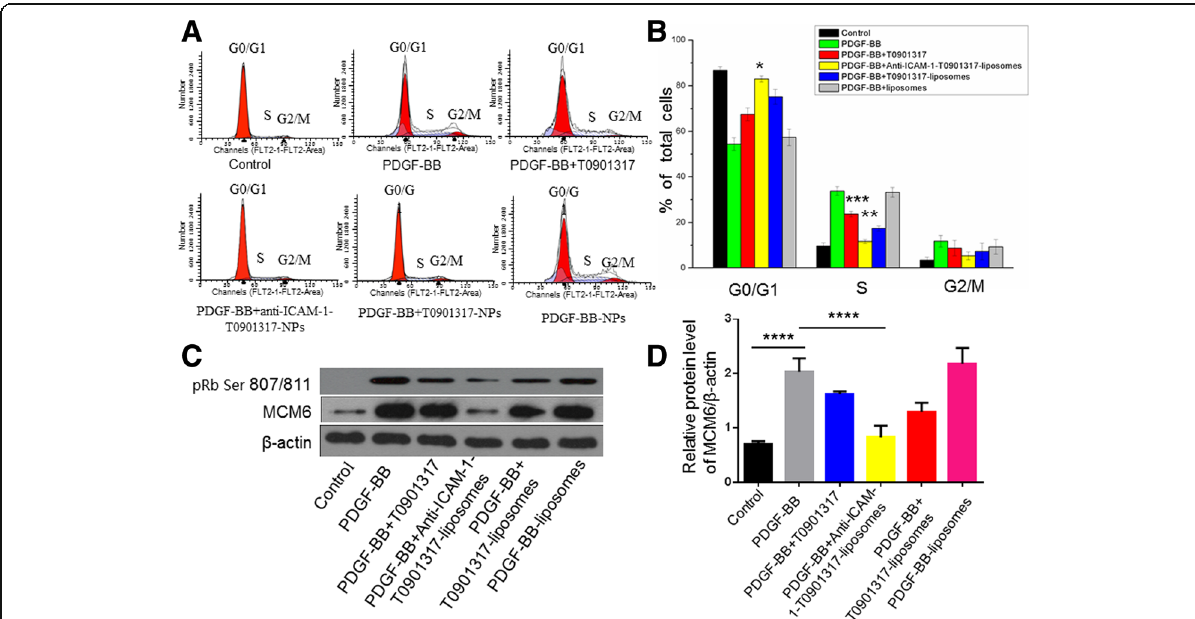
Fig. 7 Anti-ICAM-1-T0901317 liposomes inhibit PDGF-BB-induced G1 → S phase progression by inhibiting Rb phosphorylation and MCM6 expression. Cells were pre-treated for 24 h with PDGF-BB (20 μ g/mL) followed by treatment with targeted and nontargeted liposomes, T0901317, or control liposomes. a Cell cycle progression was assessed by flow cytometry. Anti-ICAM-1-T0901317 liposomes caused cells to remain in G1. b Cell cycle quantification is represented by the histogram. c Whole-cell proteins were assayed by western blotting. d Bar graphs showing the quantification of western blots. Data are expressed as a percentage of the control. Values were expressed as the means±SD ( n =3). ** P